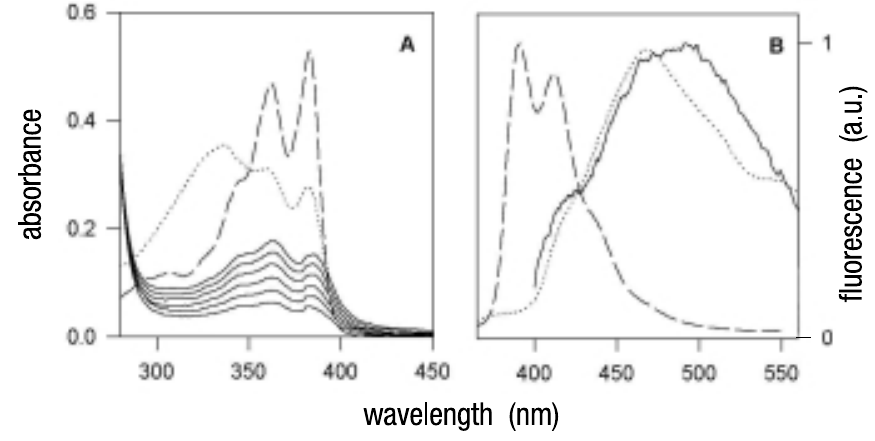
Fig. 2 – (A) Absorption spectra of DPN films with 6, 8, 10, 12, 14 and 16 layers on each side of a glass slide (—) and of DPN ([4 × 10 − 6 M]) solutions (5 cm path length) in CH 3 CN ( ··· ) and water (- - -). (B) Emission spectra of a DPN film with 16 layers on each side of a glass slide (—) and of DPN ([5 × 10 − 6 M])solution in water (- - -). The emission spectrum of a suspension of microcrystalline N,N’-dibutyl-1,4,5,8-naphthalenediimide in water is also shown ( ··· ). Spectra are normalized to I max = 1, and λ ex = 310nm in all